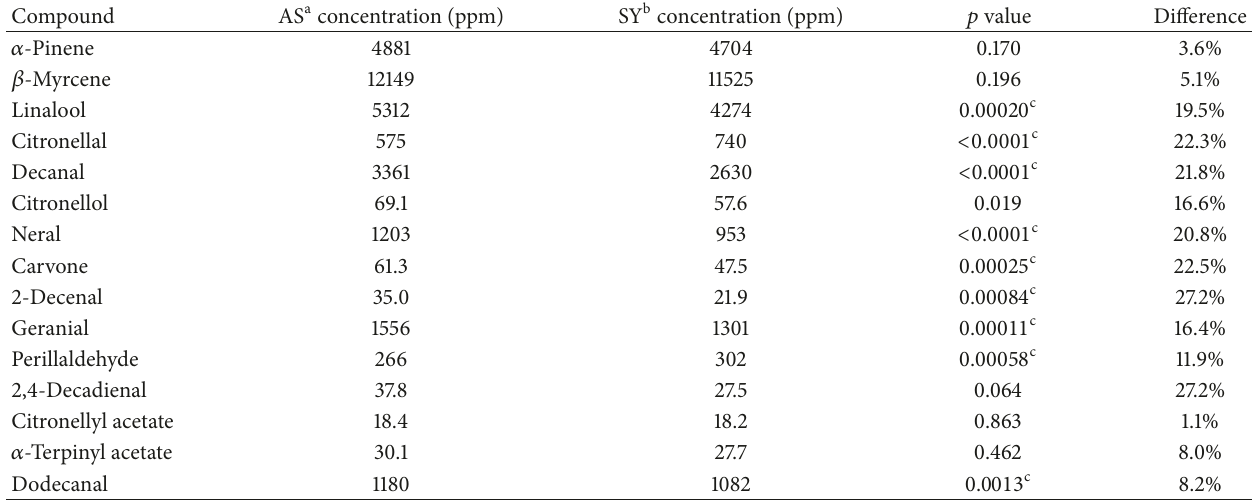
Table 5: Valencia early asymptomatic versus symptomatic compound